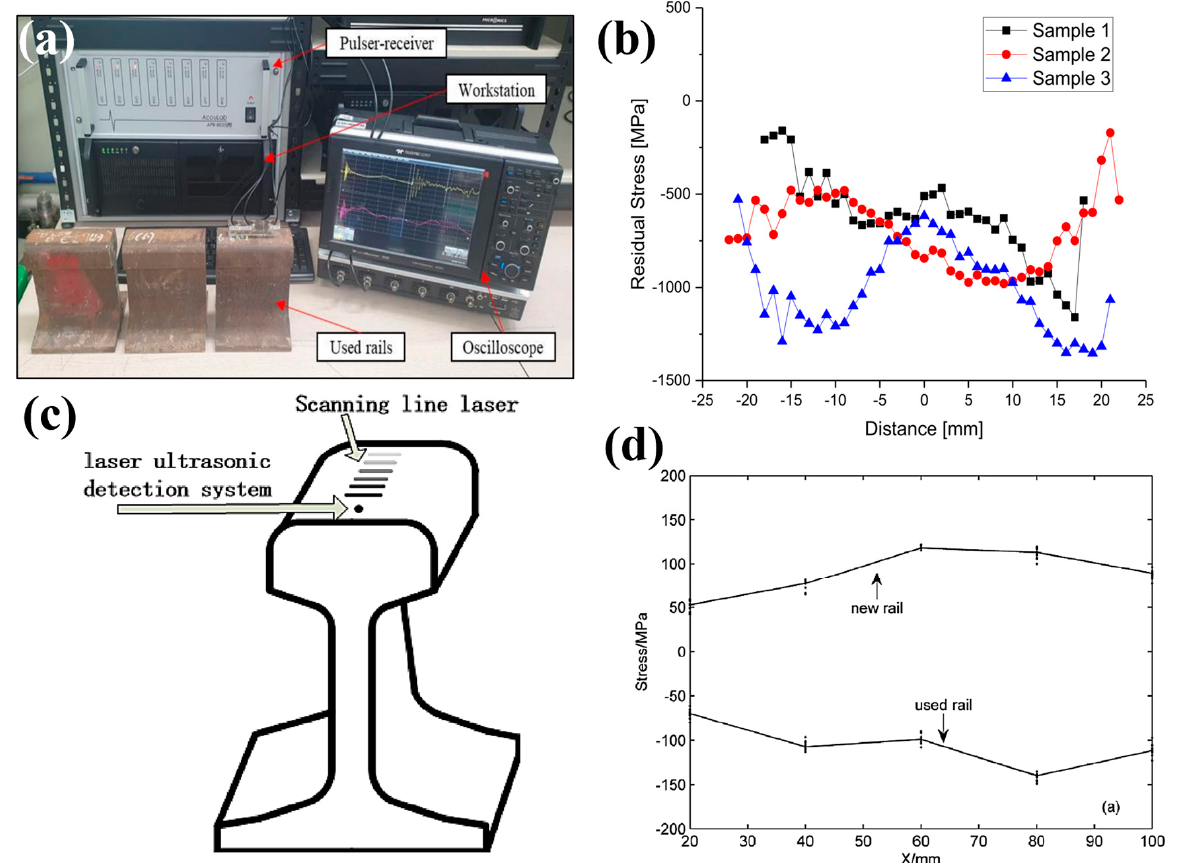
Figure 11. Study by Hwang et al. [37] showing the ( a ) experimental setup for ultrasonic measurements on rails and ( b ) stress profiles for three rail sections. Study by Wang et al. [98] showing ( c ) ultrasonic setup for tread analysis and ( d ) comparison of new and used rail tread stress